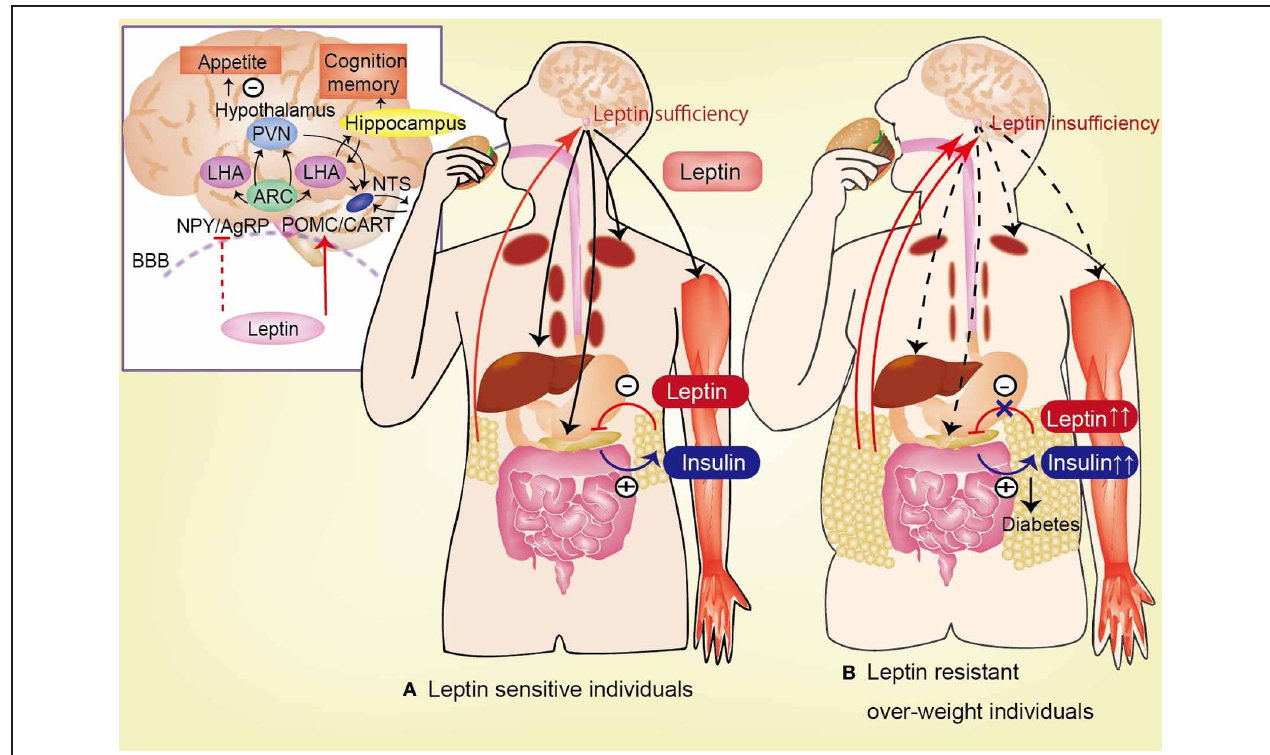
FIGURE 2 | Circulating leptin is correlated with the degree of adiposity and is transported across the blood-brain barrier (BBB). In hypothalamus, leptin activates POMC and CART neurons, and inhibit NPY and AgRP neurons, lead to anorexia. Leptin has effect to feeding behavior, appetite, insulin-glucose axis, and cognitive function. (A) In leptin sensitive individuals, leptin inhibits insulin biosynthesis and secretion from pancreatic β -cells. By contrast, insulin stimulates leptin secretion from adipose tissue. Leptin stimulates hepatic gluconeogenesis and hepatic insulin sensitivity via the hepatic branch of the vagus nerve. Additionally, leptin increases glucose uptake in the skeletal muscle, heart, and brown adipose tissue (BAT) via the